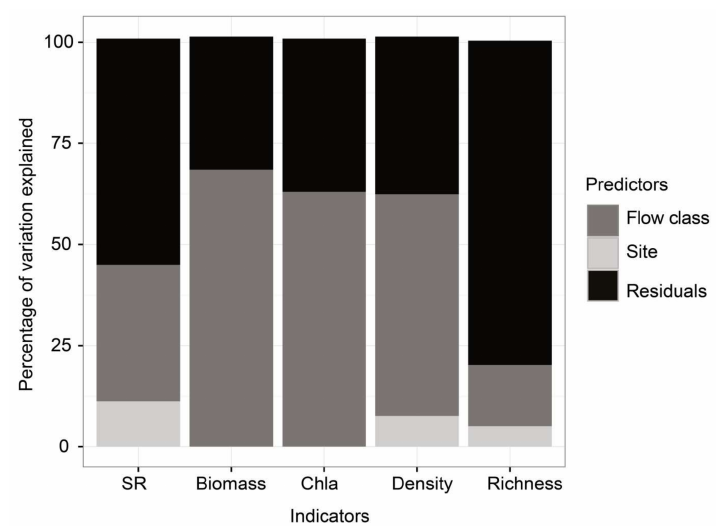
Figure 4. Partitioning variation of ecosystem structure and function measures (percentage of variation explained by flow class and site). All proportions of explained variance were significant ( p < 0.05). SR = sediment respiration; Chl-a = periphyton chlorophyll; Density = macroinvertebrate density; and Richness = macroinvertebrate taxonomic richness.